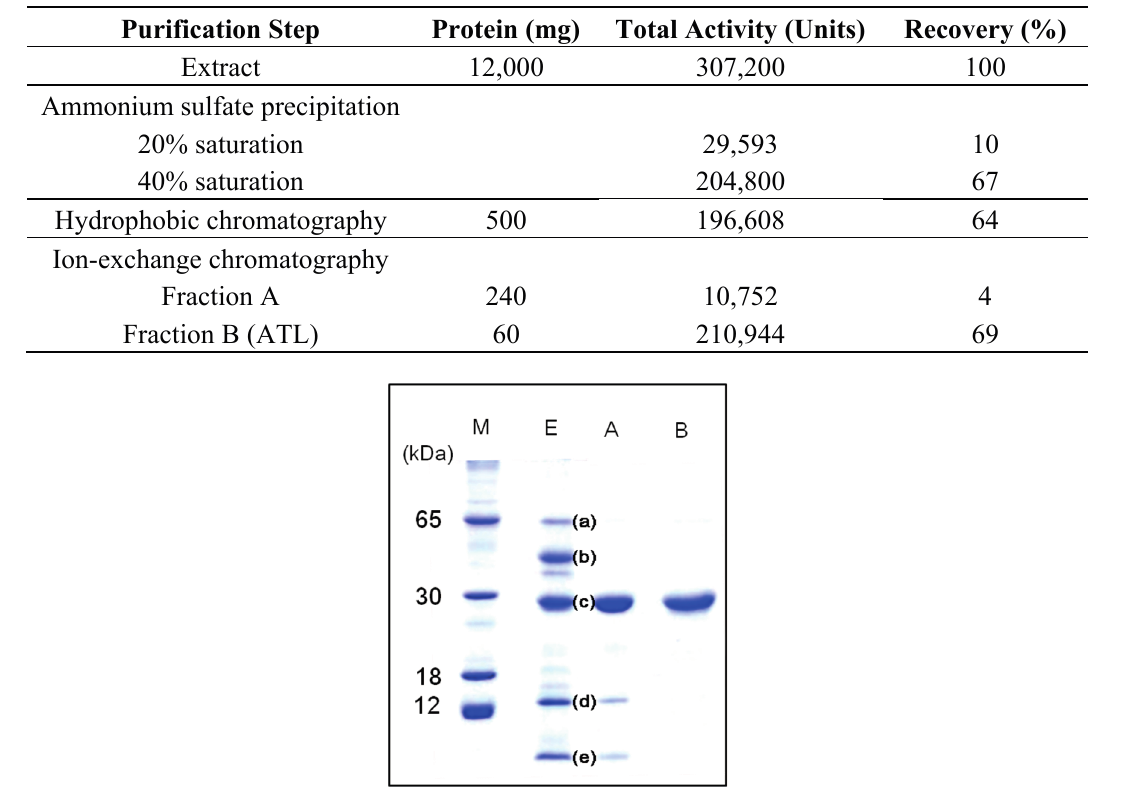
Table 1. Summary of the purification of Apios tuber lectin (ATL).